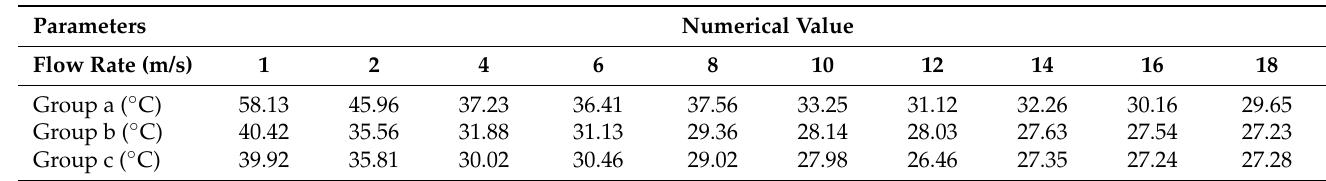
Table 3. Average static temperature values of three water-cooled plate surfaces at different inlet flow rates.